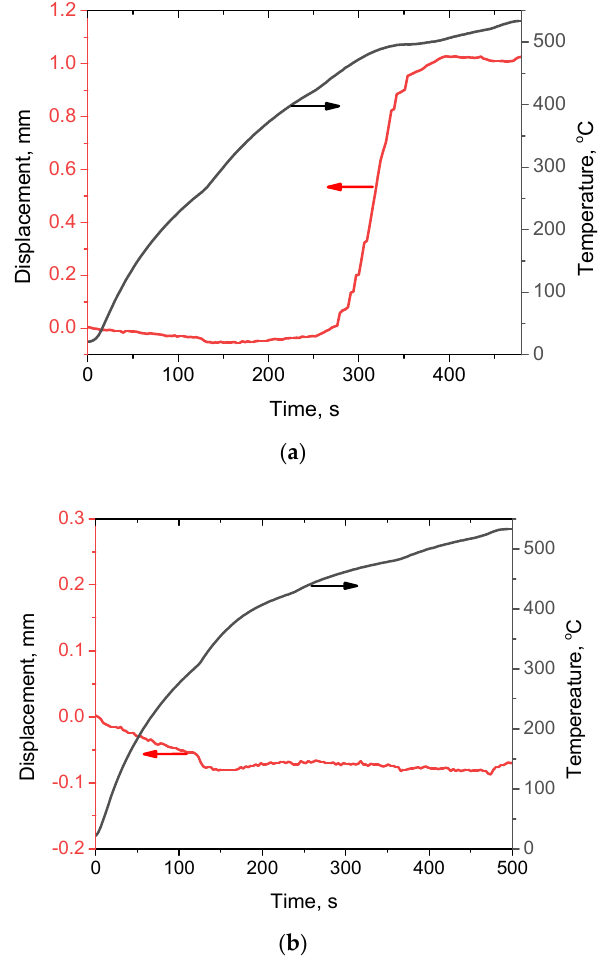
Figure 9. Temperature and displacement versus time during spark plasma sintering (SPS) of the glassy Fe 66 Cr 10 Nb 5 B 19 ( a ) and crystalline Fe 62 Cr 10 Nb 12 B 16 ( b ) alloy powders. Black lines—temperature; red lines—displacement. Reprinted from [82]. This article is an open access article distributed under the terms and conditions of the Creative Commons Attribution (CC BY) license (https://creativecommons.org/licenses/by/4.0/).